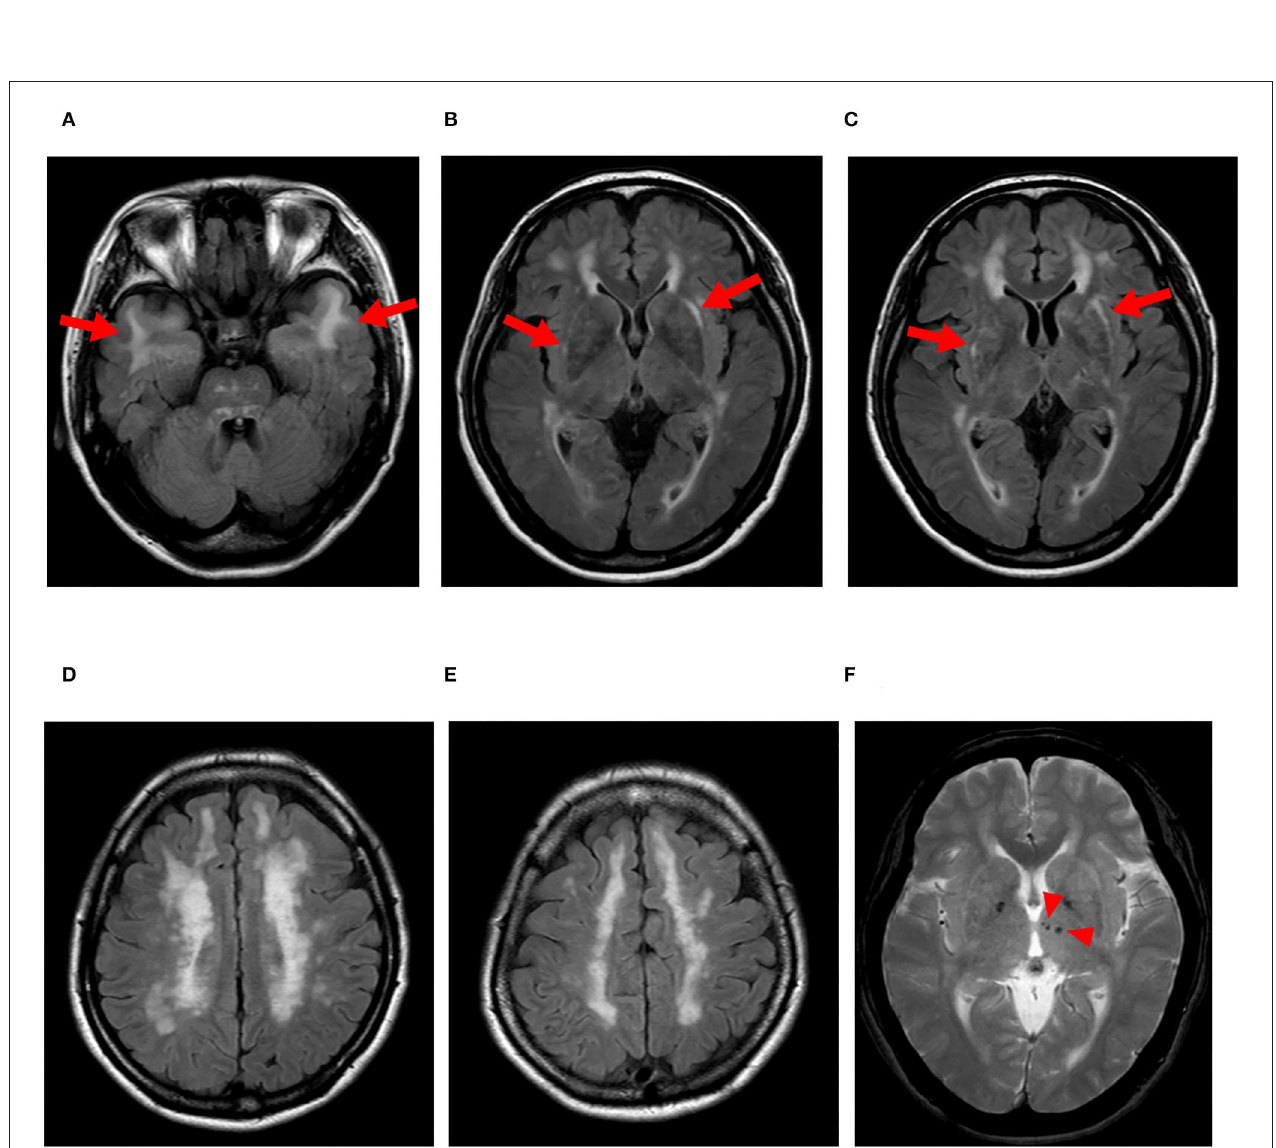
FIGURE 2 | Representative MRI findings of CADASIL. Case 2 with the pathogenic NOTCH3 p.Arg110Cys variant. (A–E) FLAIR images, (F) T2-star weighted image. (A) Arrows indicate lesions in the temporal pole. (B,C) Arrows indicate lesions in the extra capsule of the putamen, and (F) arrowheads indicate microbleeds.